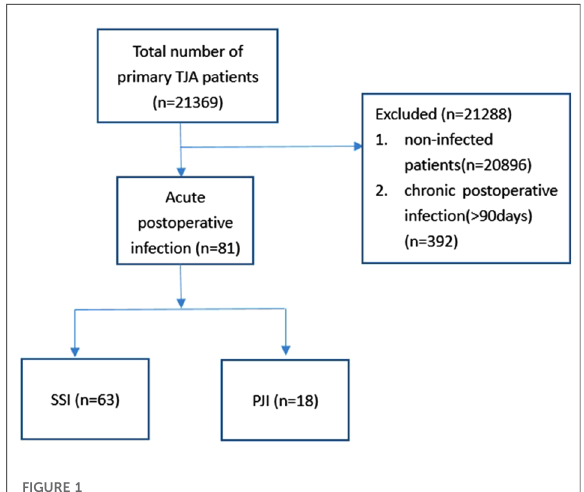
FIGURE 1 Flow chart showing the identi fi cation of the included infected